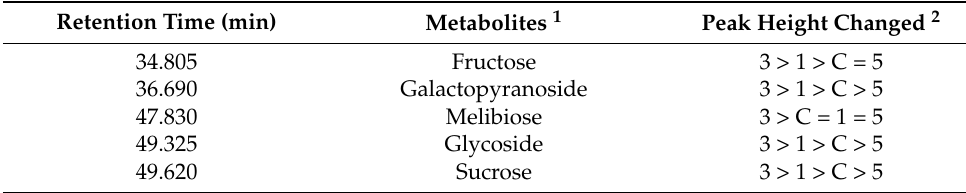
Table 3. Candidate metabolites in rice stem